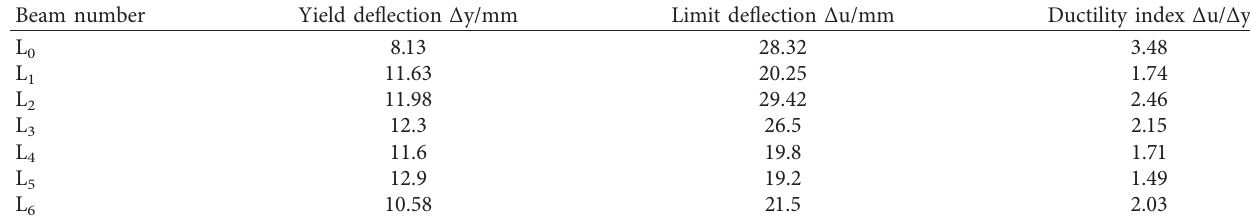
～ L 0 6 ductility index.